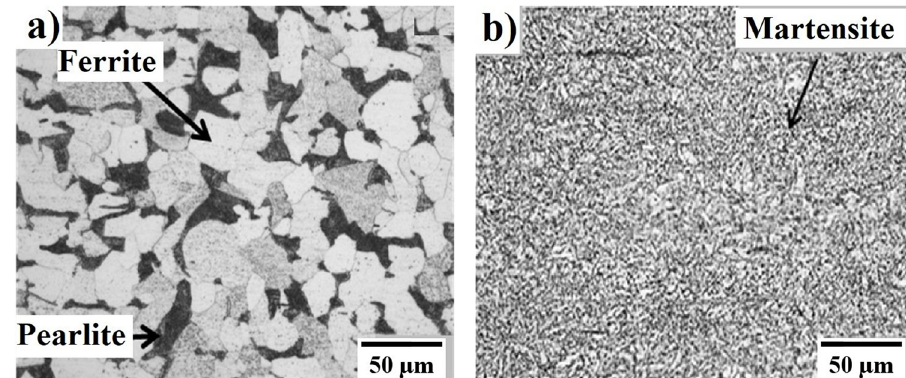
Figure 9: Optical microstructure of PM: ( a ) AISI 1018 steel and ( b ) AISI 431 steel.